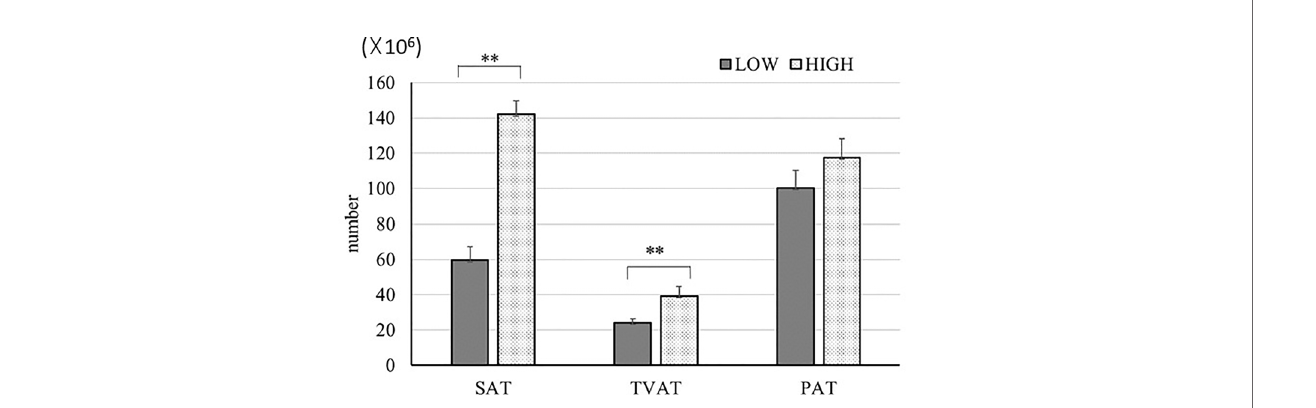
FIGURE 6 | Estimation of adipocyte number in SAT, TVAT, and PAT of LOW and HIGH fetuses. Values were calculated based on the values from adipocyte diameter analysis ( Figure 1 ) and data of each adipose tissue mass. Adipose tissue density: 0.92 g/cm 3 (54). Fetuses: 260 ± 8.3 days of fetal age. LOW: n=6. HIGH: n=6. Values are means with standard errors. Signi fi cant differences between fetal groups are denoted by ** p